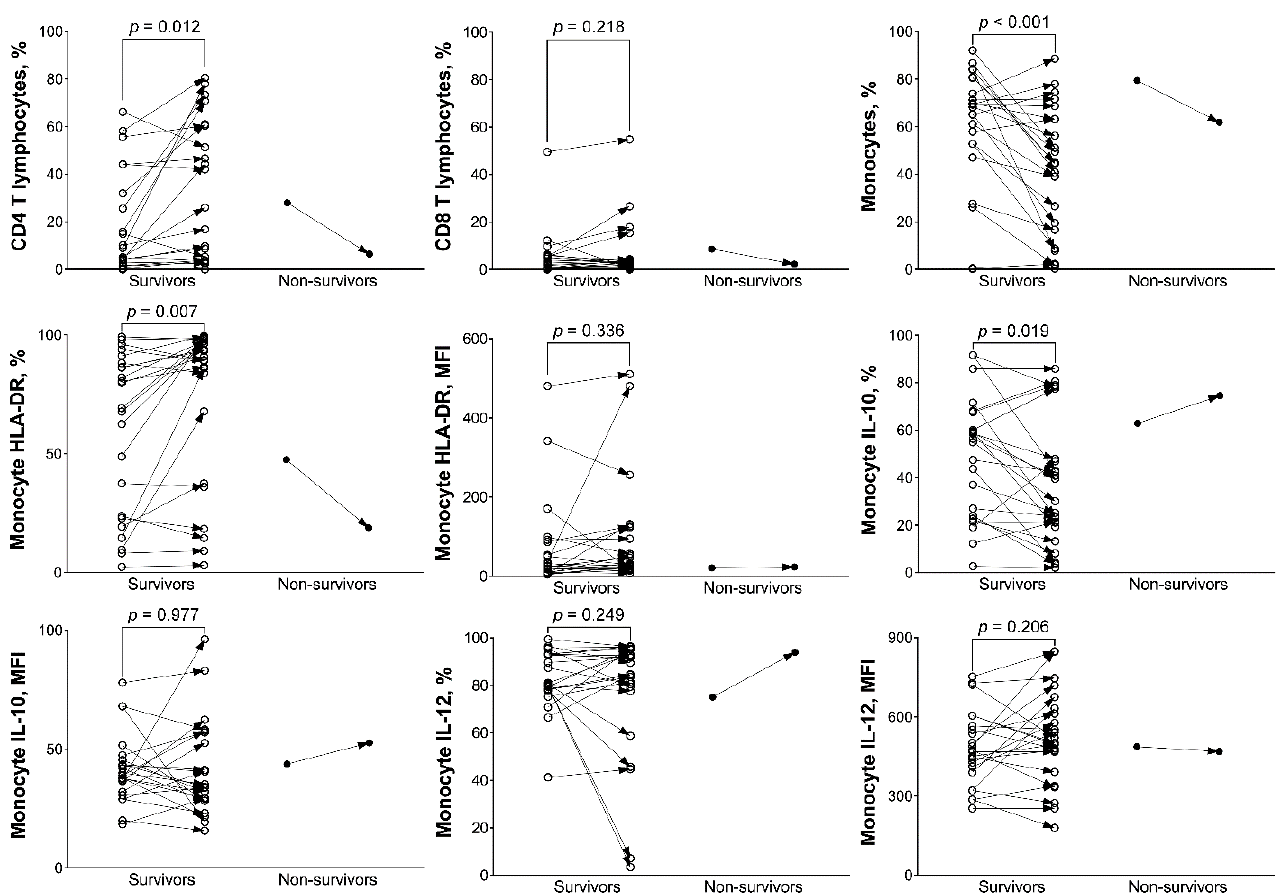
Figure 2. Percentages of bronchoalveolar lavage mononuclear cells, monocyte human leukocyte anti- gen (HLA)-DR expression, and monocyte intracellular interleukin (IL)-10/IL-12 expression between days 1 and 8 in survivors and non-survivors. Percentages of CD4 T lymphocytes and monocyte HLA-DR expression in percentage increased after 7 days in survivors. Monocyte HLA-DR expression in mean fluorescence intensity (MFI) did not change after 7 days in survivors. Monocyte percentage and monocyte IL-10 expression in percentage decreased after 7 days in survivors. Monocyte IL-10 expression in MFI did not change after 7 days in survivors.